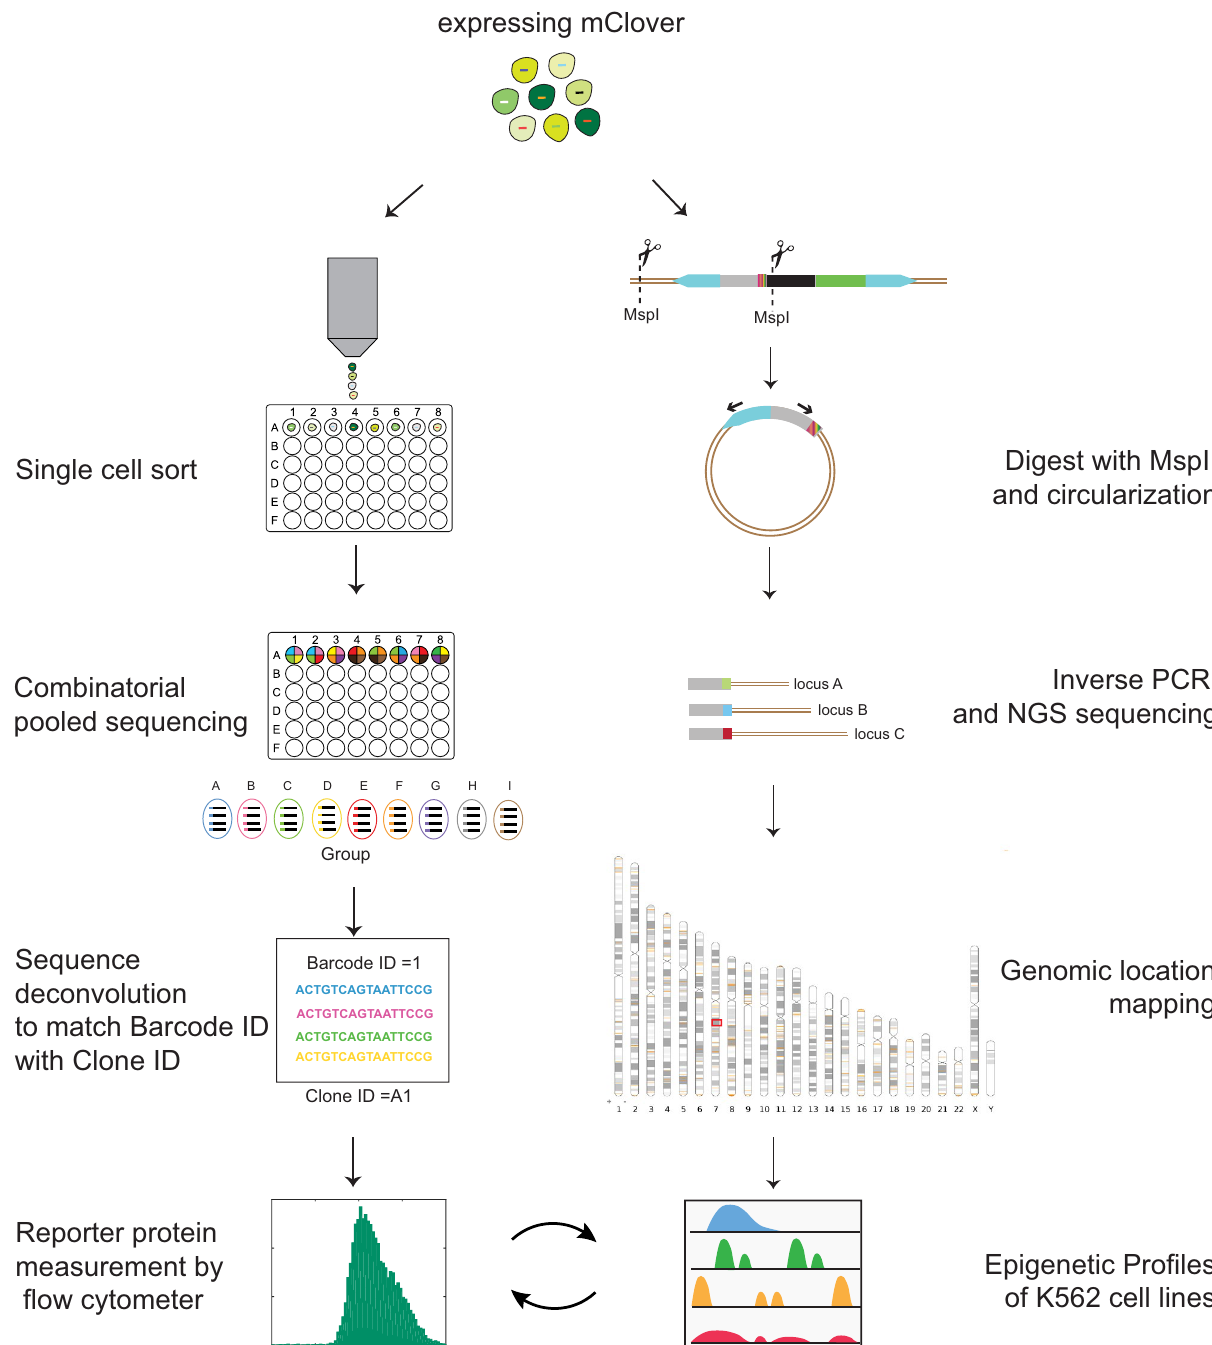
Figure 1. Protocol for scalable and parallel measurement of expression distribution and genomic position of reporter genes. ( A ) Two high-throughput methods were connected by incorporating random 16-bp DNA barcodes in the reporter cassette containing identical CMV promoter and a gene coding for fluorescent protein Clover. Synthetic reporter was introduced into K562 cells through low m.o.i. lentiviral transduction. ( B ) Pooled identification of the genomic position of reporter genes based on the unique DNA barcode using TRIP method. Extracted genomic DNA of mixed founder cells was digested with MspI and followed by inverse PCR and deep sequencing. ( C ) The creation of isogenic cell line, the identification of the DNA barcode sequence unique to each cell line using combinatorial pooled sequencing and the measurement of reporter expression distribution by high-throughput flow cytometry. The coupling of these two measurements allows the generation of large scale data on the effect of chromatin environment on gene expression